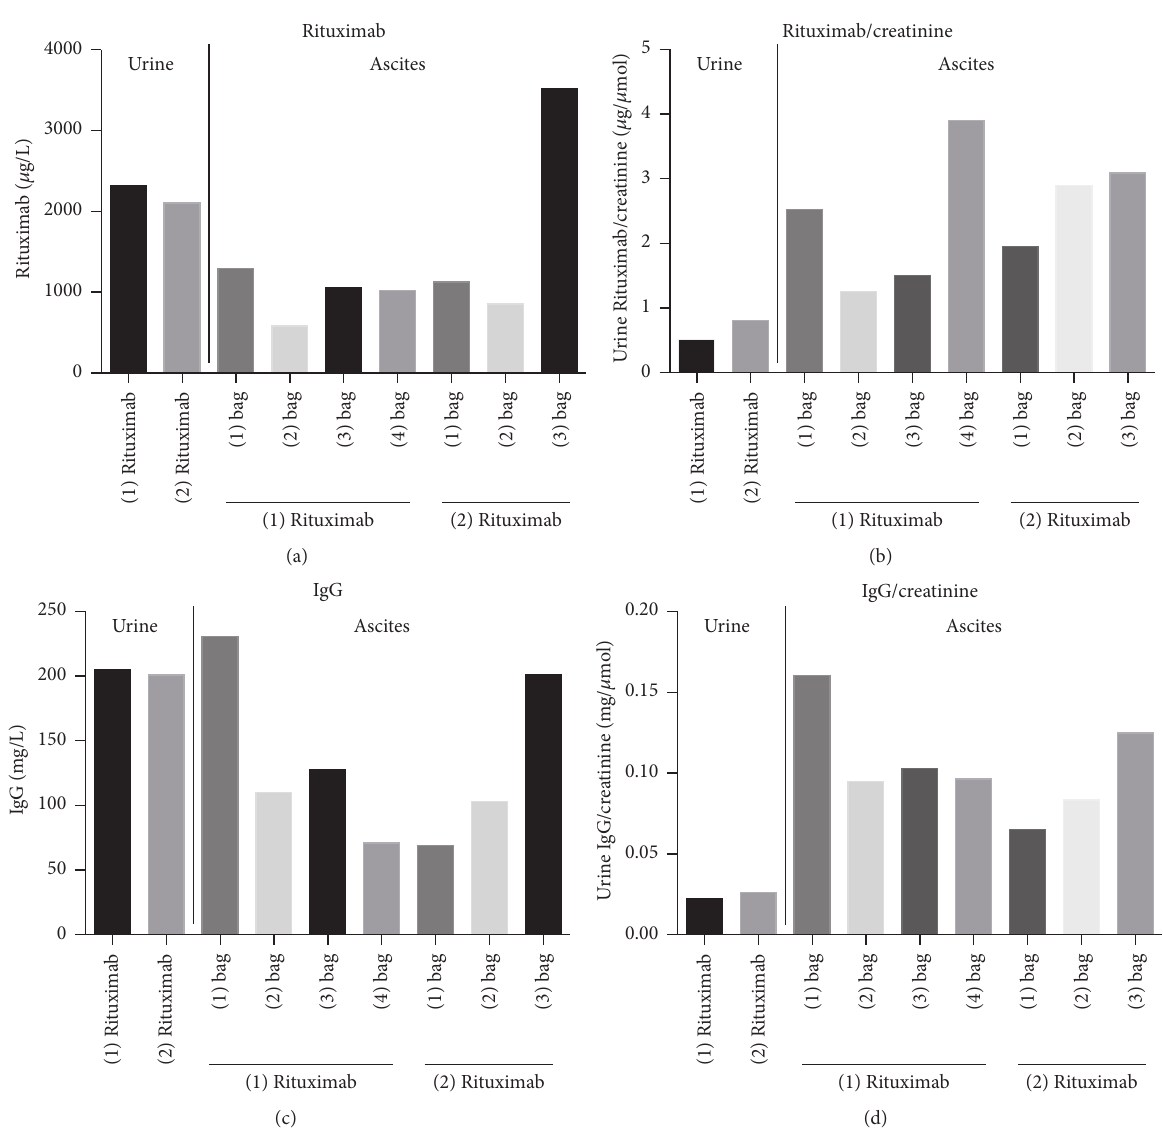
A significant amount of IgG was found in all urine and peritoneal fluid samples. IgG showed maximum urine concentration of 205 mg/L and a maximum IgG/creatinine ratio of 0.026 mg/ 𝜇 moL, while in the peritoneal fluid a maximum IgG concentration of 231 mg/L could be